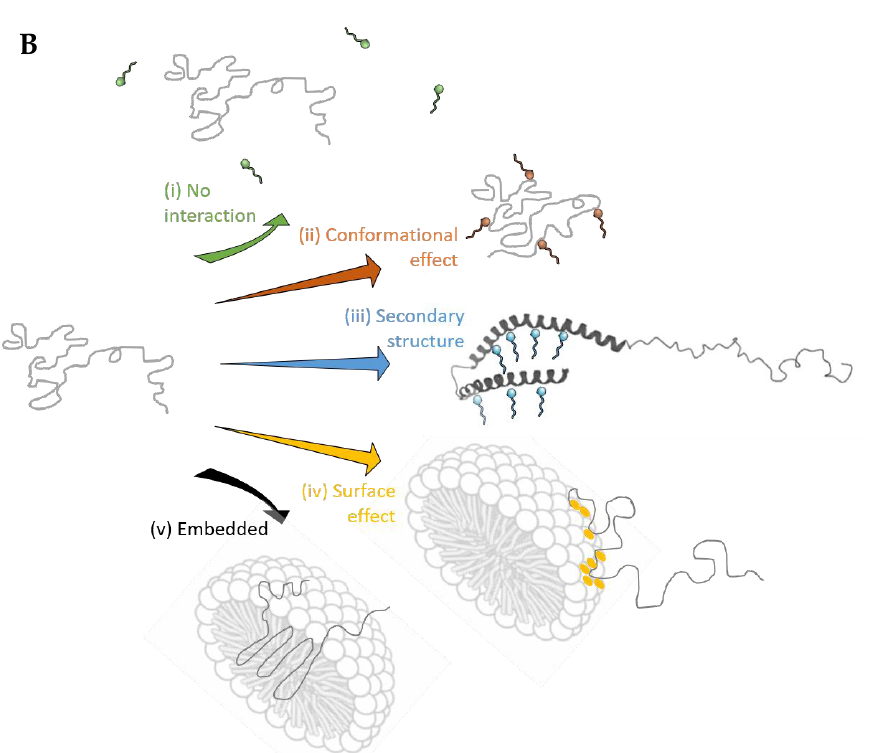
Figure 1. ( A ) Amino acid sequence of human wild-type α-syn. Negatively charged residues are in red, positively charged residues are in blue. The three different regions which can be distinguished are indicated. ( B ) Different scenarios that can occur for protein-detergent interactions. It can be that (i) no interaction is detected; (ii) that the tertiary protein conformations are altered; (iii) that secondary structure forms; (iv) that proteins interact with the surface of micelles; (v) or that they are embedded in the micelle.